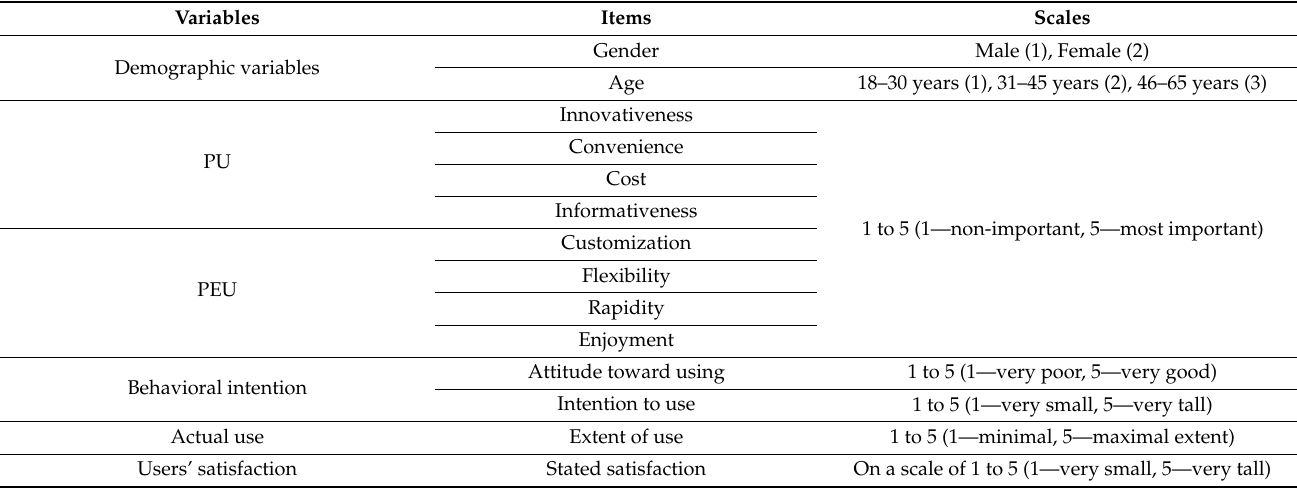
Table 1. Questionnaire design (constructs and items).